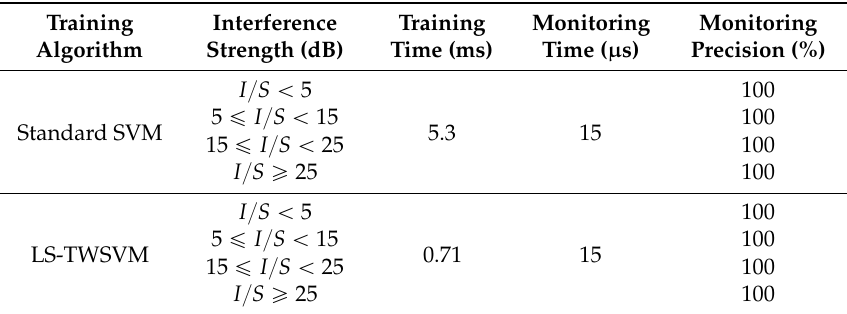
Table 2. Narrowband interference monitoring